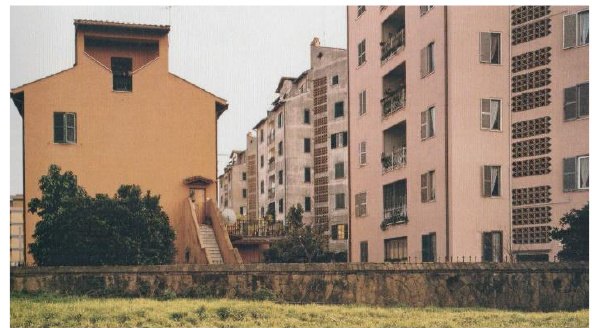
Figure 3. Recent photograph of the current state of conservation at the INA Casa Tiburtino district in Rome. (© ph. by F. Jodice).